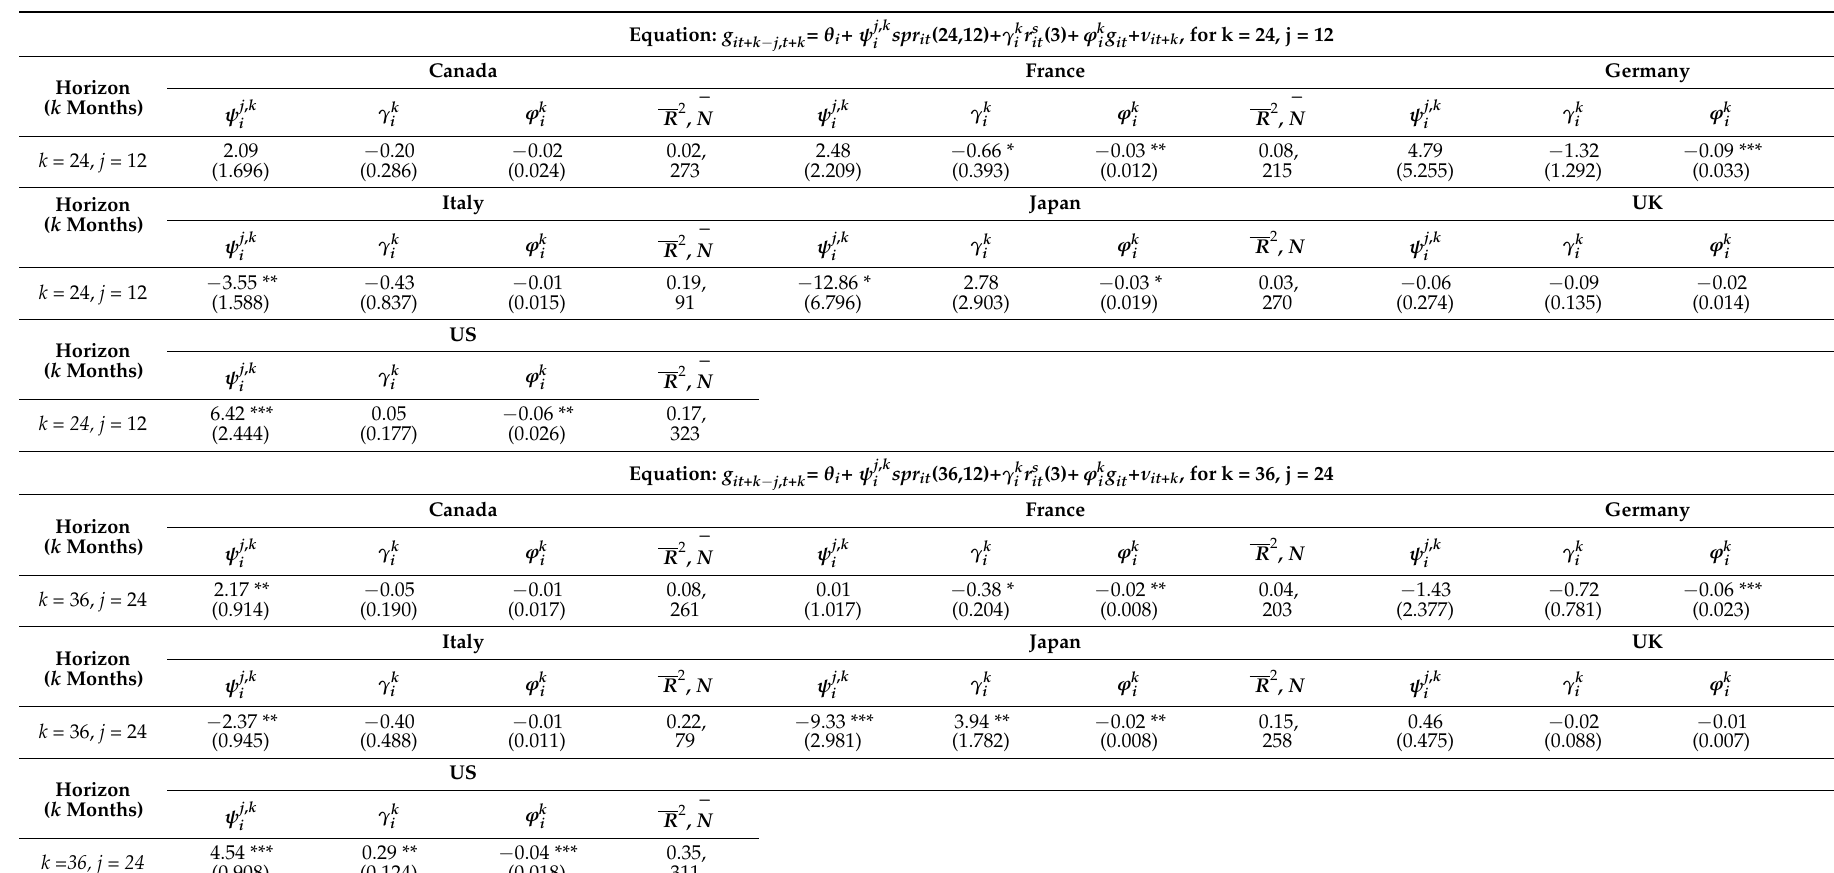
Table A4. Economic activity and term spread, short rate, and growth rate—marginal